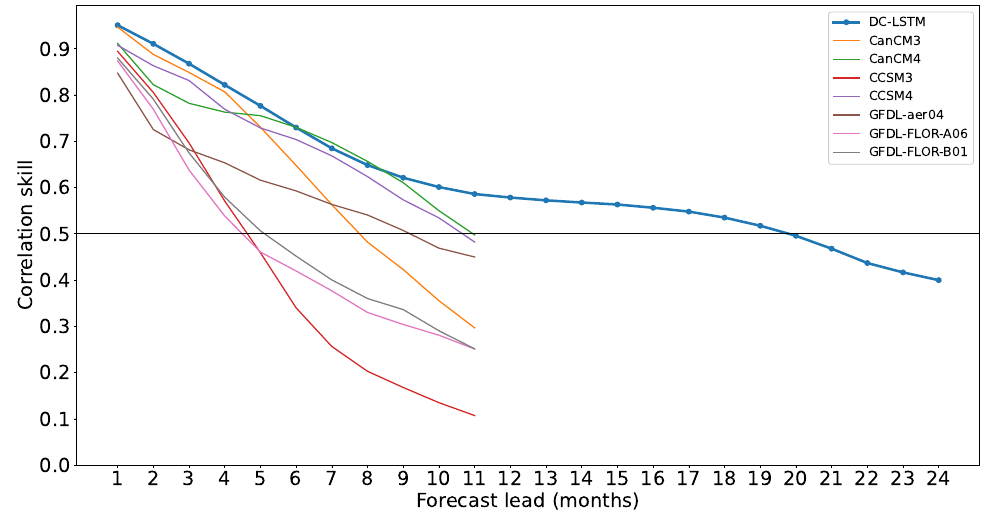
Figure 7. The improvement in the skill of the DC-LSTM model due to the historical simulation dataset.